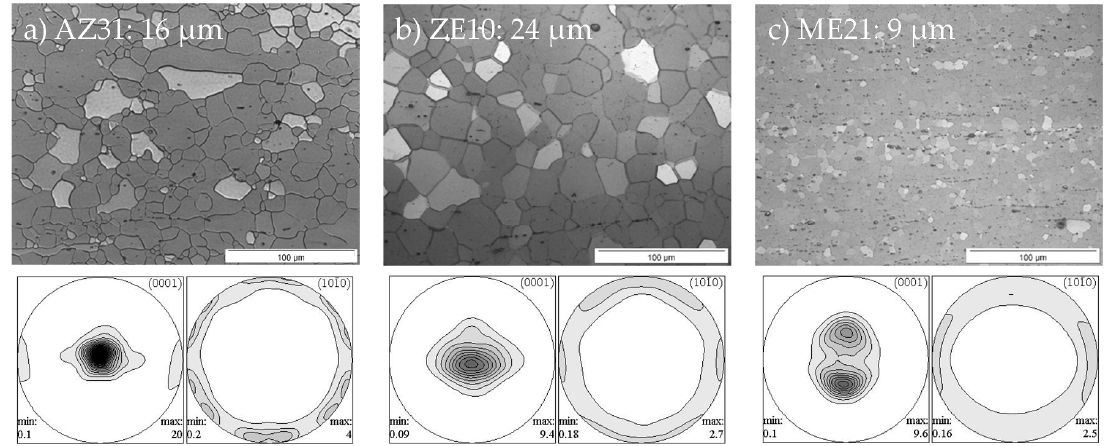
Figure 2. Same as Figure 1 for extruded and annealed sheets: ( a ) AZ31; ( b ) ZE10; ( c ) ME21 (micrographs: RD horizontal, ND vertical; pole figures: RD vertical, TD horizontal, lines in 1.0 multiples of random distribution steps).